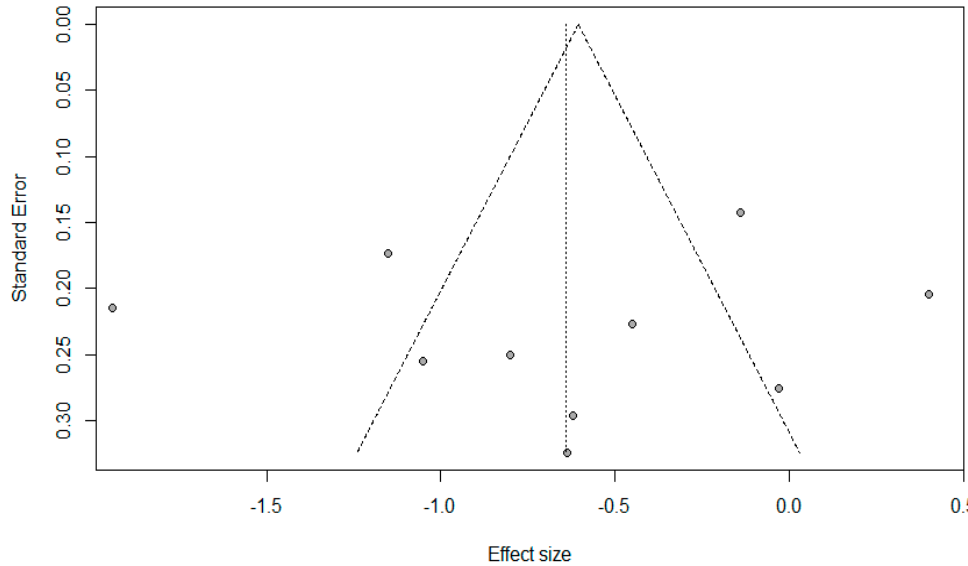
Figure 3. Funnel plot of 10 randomized controlled trials (RCTs) on the effect of VR on preoperative anxiety.